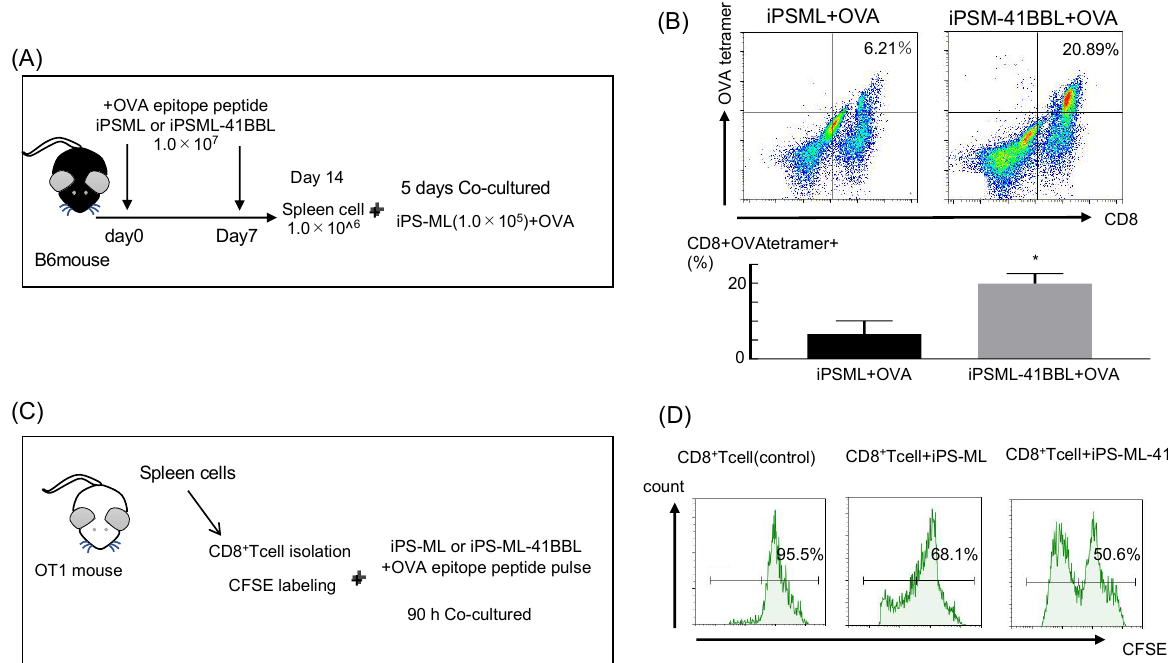
Figure 3. Antigen-presentation capacity of iPS-ML-41BBL ( A ) Model of treatment and sampling schedule; non-tumor– bearing B6 mice were intraperitoneally injected with OVA peptide-pulsed iPS-ML or OVA peptide-pulsed iPS-ML-41BBL on days 0 and 7, and the spleen tissues were harvested on day 14. Cells (1 × 10 6 cells/well) were cocultured with OVA peptide-pulsed iPS-ML (1 × 10 5 cells/well). After culturing for 5 days, the floating cells were collected and analyzed by FCM. ( B ) FCM analysis of OVA-specific CD8 + T cells. * p < 0.05. ( C ) Carboxyfluorescein succinimidyl ester (CFSE)-labeled CD8 + T cells from OT-I transgenic mice and no cell, OVA peptide-pulsed iPS-ML or OVA peptide-pulsed iPS-ML-41BBL were cocultured at 1:1 dilutions. ( D ) Proliferation of OT-I cells was assessed after 72 h by flow cytometry. * p <